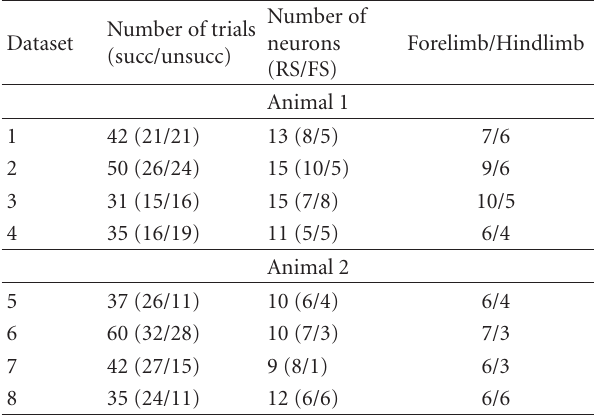
Table 1: Summary of experimental data in the present